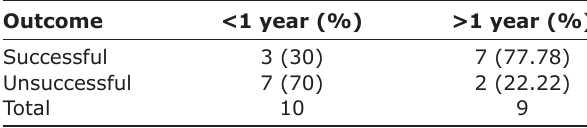
Table-3: Age wise success of C-arm guided IM pinning.